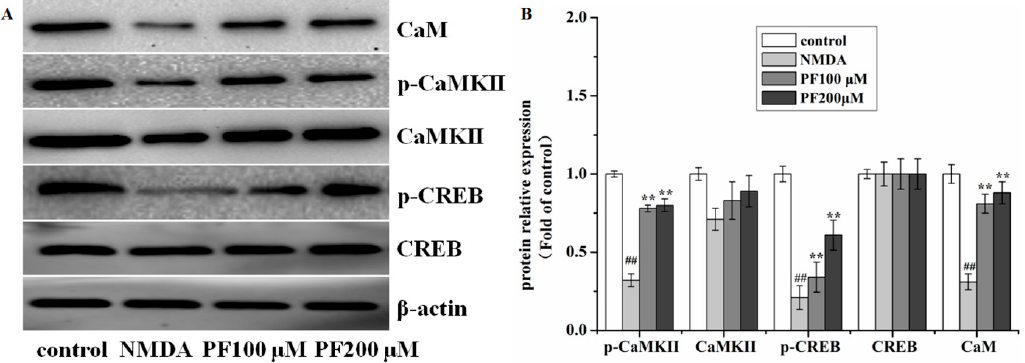
Figure 6. Effects of PF on the expression in the Ca 2+ /CaMKII/CREB signaling pathway in neurons after NMDA-induced excitotoxicity. ( A ) Western blot and ( B ) the relative optical densities analysis of the level of CaM, CaMKII, p-CaMKII, CREB, p-CREB. β -actin was used as the internal controls. All data were presented as mean ± SD. ## p < 0.01 vs. control;, ** p < 0.01 vs. NMDA.